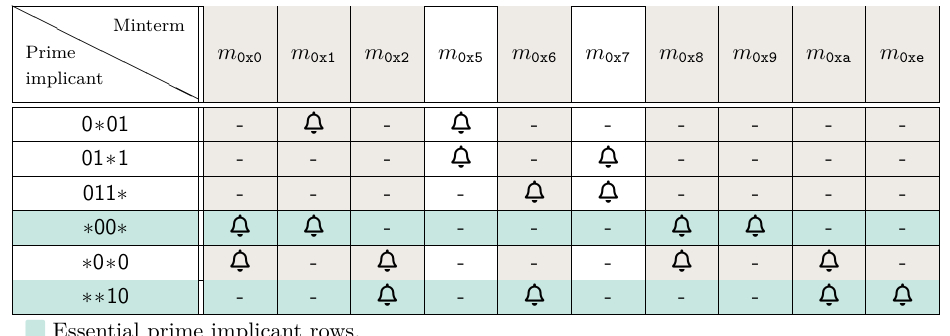
Table 2: Prime implicant chart of f